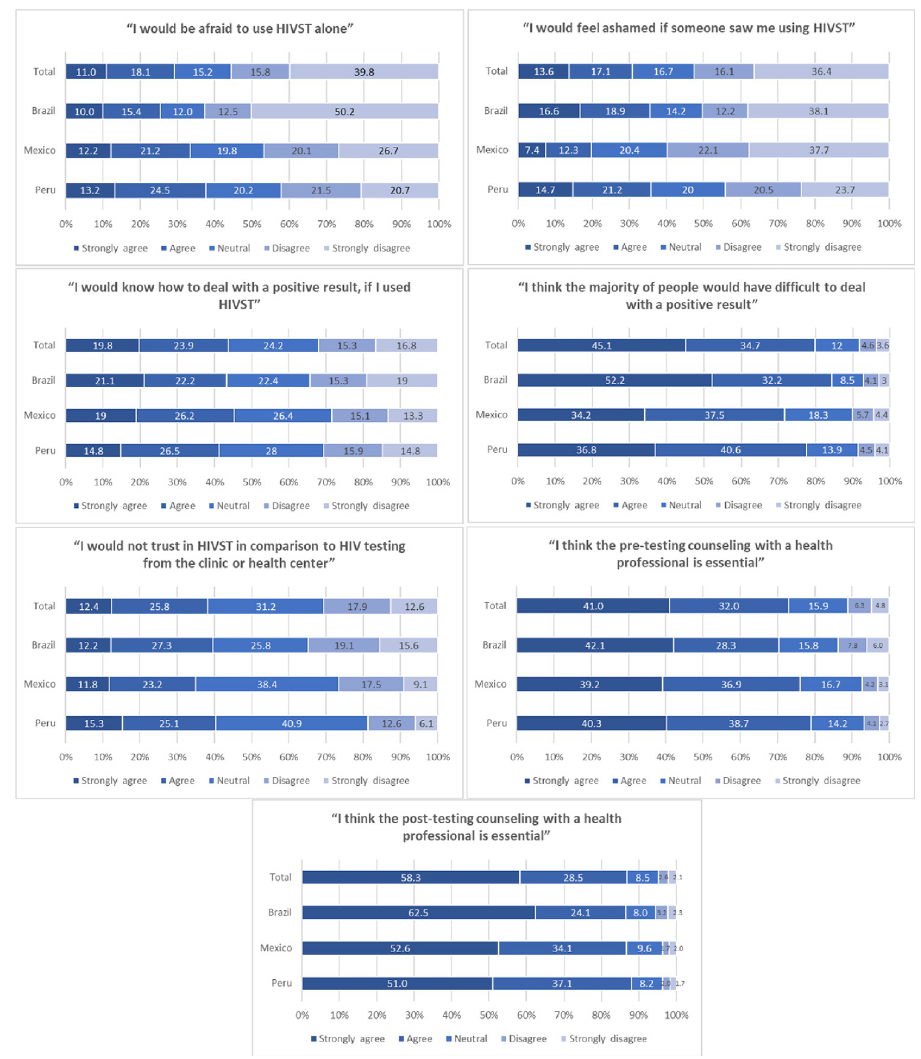
Fig 3. Barriers to use HIVST among MSM in Brazil, Mexico, and Peru,